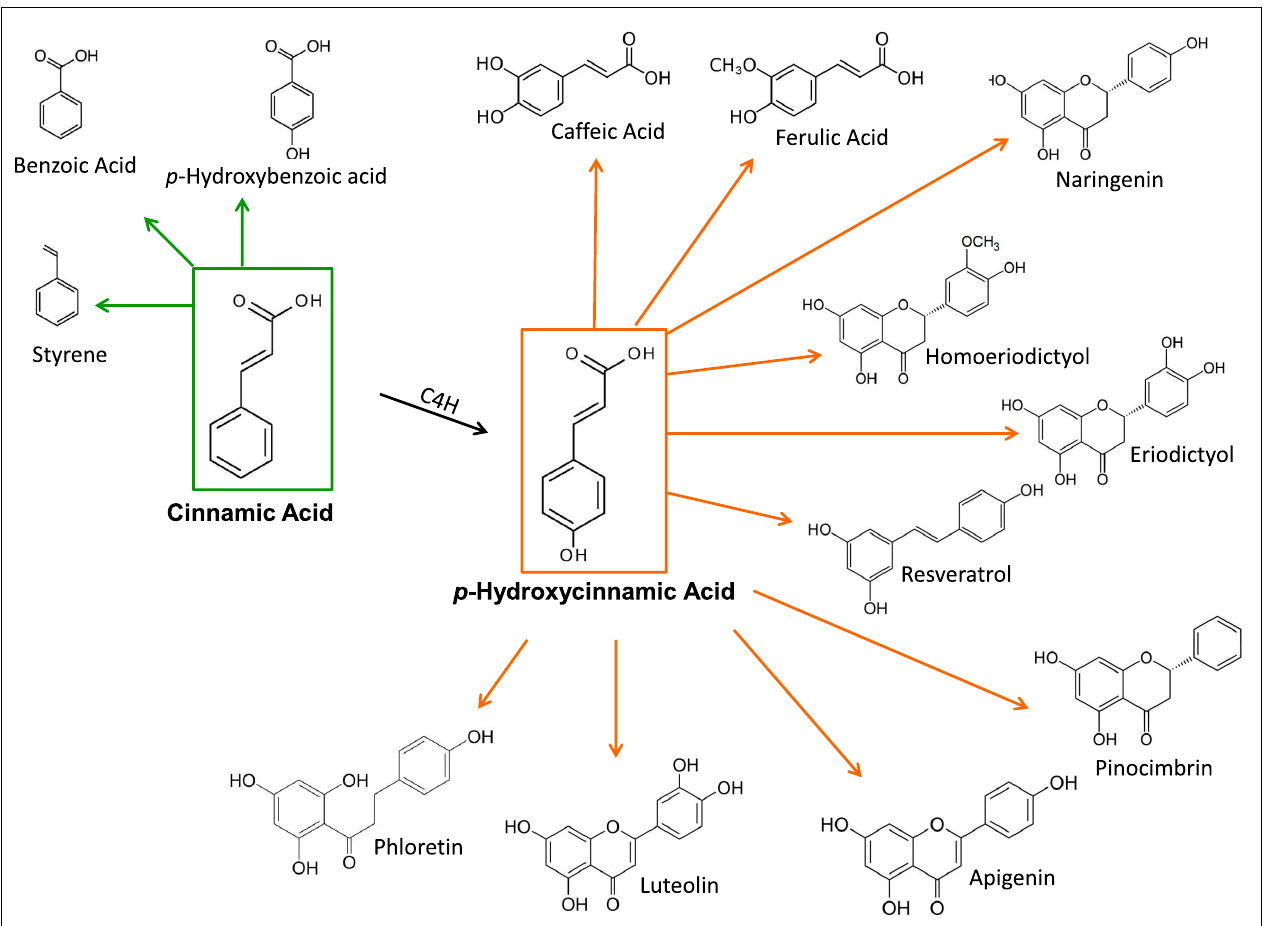
FIGURE 2 | Plant metabolites produced from CA and pHCA by engineered microbial strains